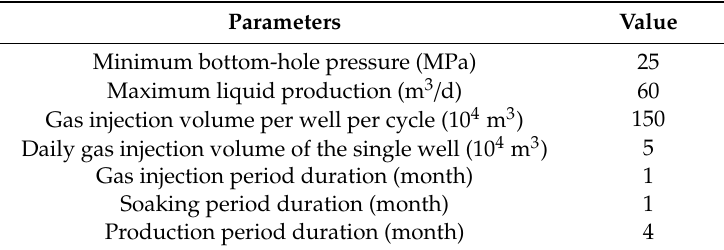
Table 5. Schedule of CO 2 hu ff -n-pu ff and AIIP